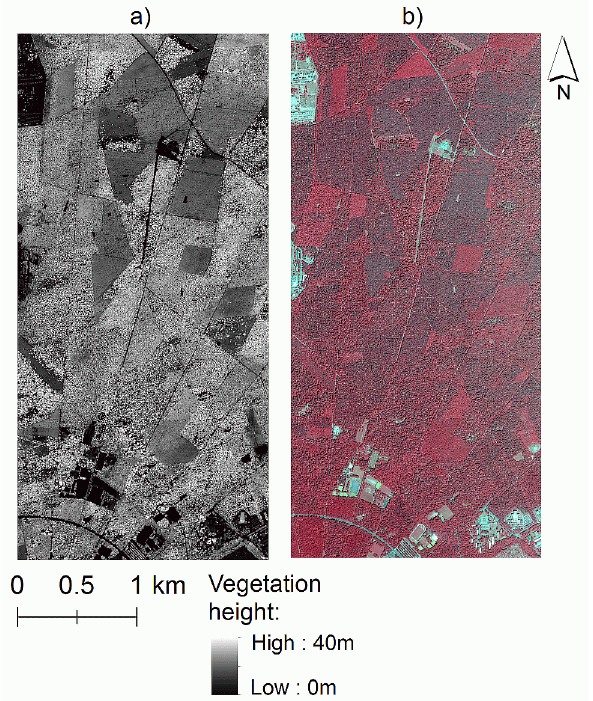
Figure 1. (a) Vegetation height model from ALS and (b) Color-infrared orthophoto from multispectral line scanner data of the study area near Karlsruhe, Germany.